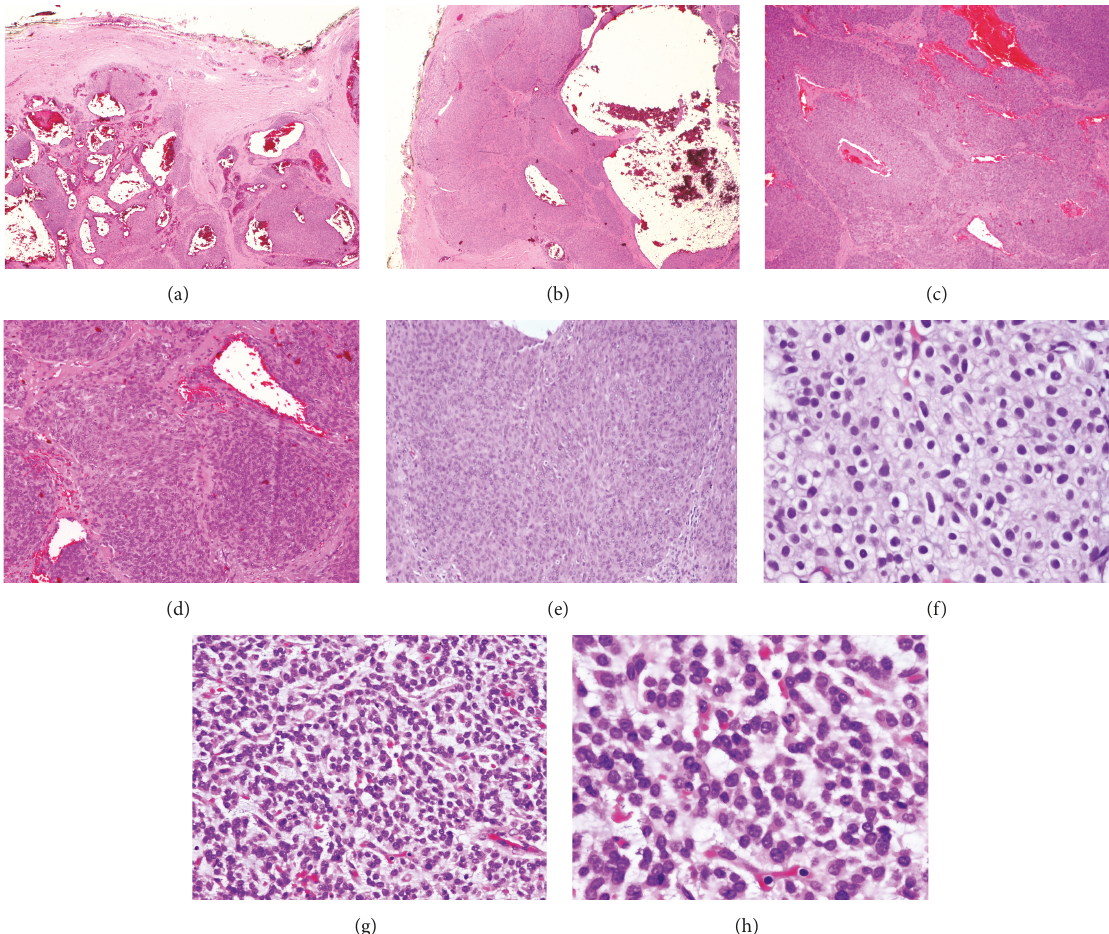
Figure 2: (a) Low-power view of multilobular growth pattern with lobules containing markedly expanded vascular spaces; the lobules are separated by fibrous bands (H&E; × 40). (b) Well-demarcated but uncapsulated tumor demonstrating large gaping vascular spaces surrounded by clusters of glomus cells (H&E; × 100). (c) Tumor cells exhibiting nodular growth pattern, no necrosis seen (H&E; × 100). (d) Sheets and nests of bland cells with oval nuclei with stromal hyalinization (H&E; × 200). (e) Focal areas adjacent to the vascular spaces show solid glomus tumor, consisting of nodules of bland small round to oval monotonous cells with low mitosis (H&E; × 100). (f) Round to ovoid glomus cells with hypercellularity and distinct cell borders, each containing a single centralized, uniform, round, small “punched out” nucleus (H&E; × 400). (g) Glomus tumor forming trabeculae in abundant myxoid areas (H&E; × 200). (h) Small, round, uniform, and with pale eosinophilic to amphophilic cytoplasm (H&E; × 400).